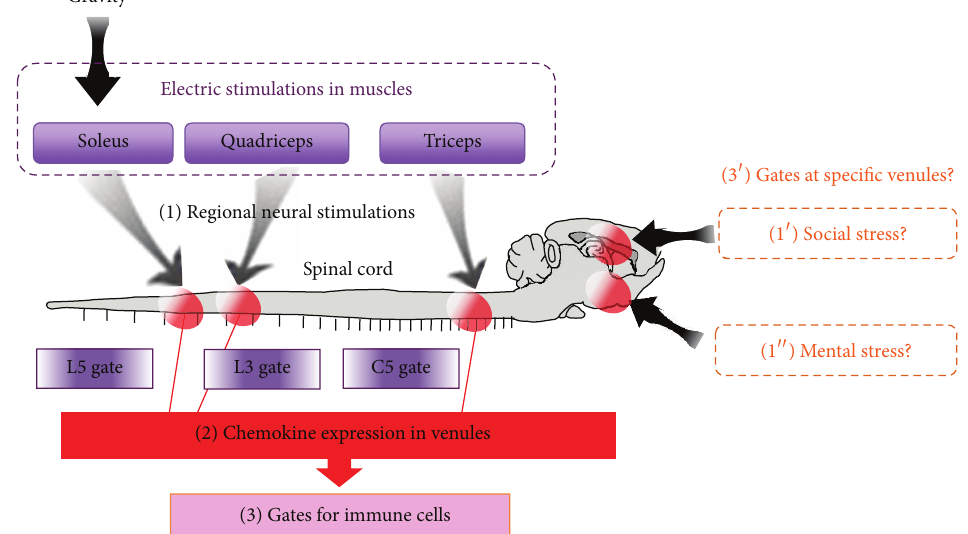
Figure 6: Each neural stimulation establishes a regional gate of immune cells in the CNS. Gravity or electric stimulations to soleus muscles can open the L5 gateway via regional neural stimulations-mediated chemokine expression, electronic stimulation of the quadriceps followed by neural stimulation establishes the L3 gateway, and gateways in the fifth cervical to fifth thoracic cord vessels were created by electric stimulations to triceps brachii. Therefore, it is reasonable that neural stimulations induced by stresses like social and mental ones might establish gates in some specific sites of the